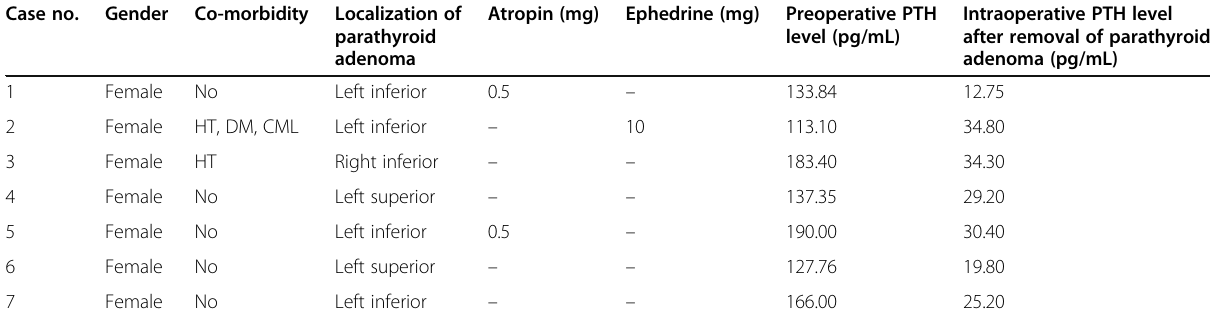
Table 1 Demographic data and preoperative and operative details Case no.